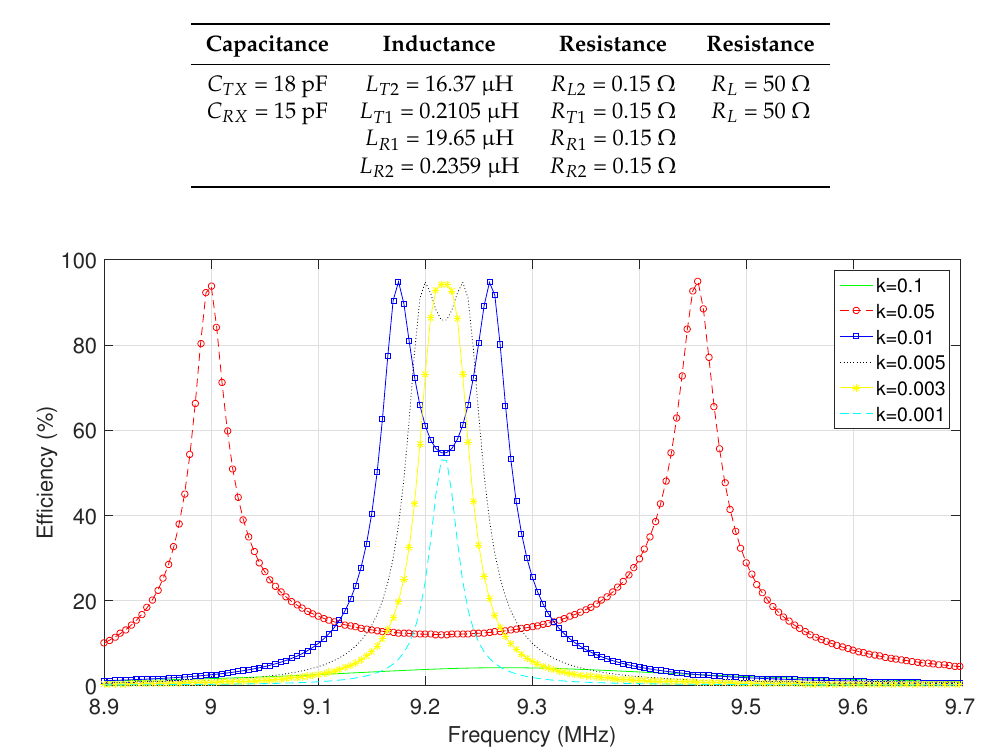
Table 3. Calculated values of the elements used in the proposed model with two loop loosely coupled WPT system with a low Q of the coils and two additional inductors.